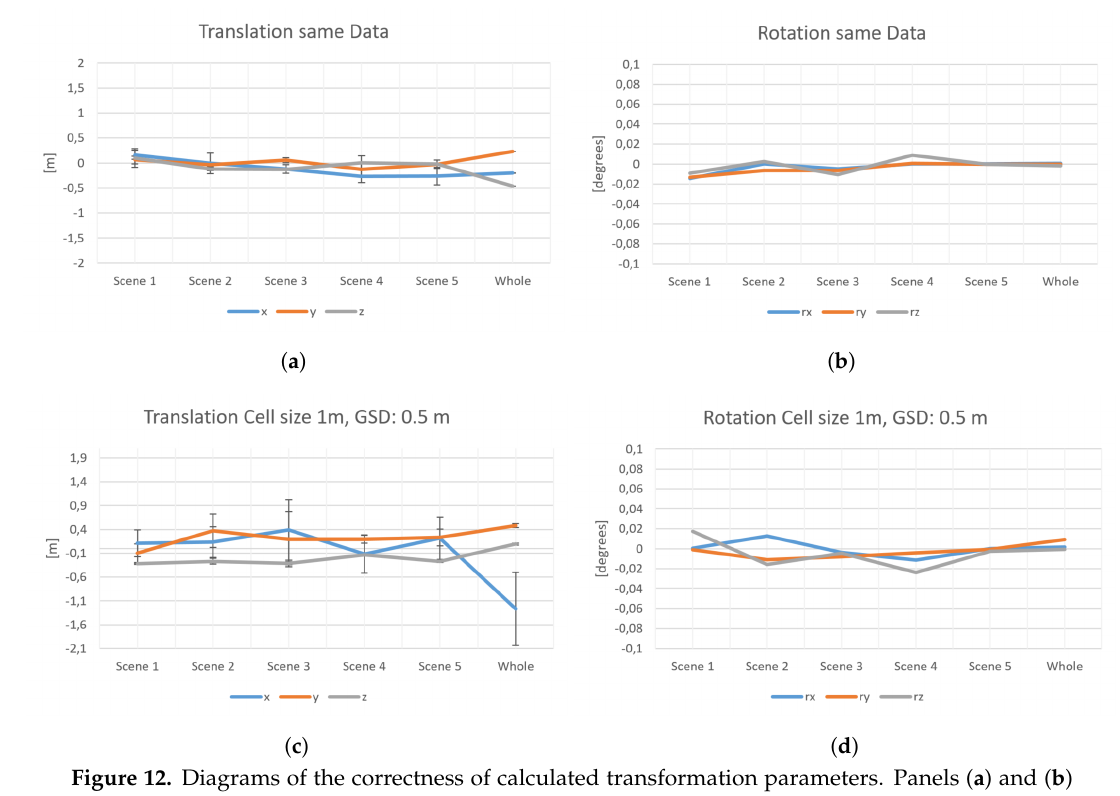
Figure 12. Diagrams of the correctness of calculated transformation parameters. Panels ( a ) and ( b ) show the transformation evaluated on the same data with translation parameters ( a ) and rotation parameters ( b ). Panels ( c ) and ( d ) show the transformation evaluated on the data corresponding to a GSD of 0.5 m with translation parameters ( c ) and rotation parameters ( d ). It should be named that there is a change of the grid cell size between the single scenes and the whole data. Single scenes are evaluated using a cell size of about 1 m and the whole data using a cell size of about 4